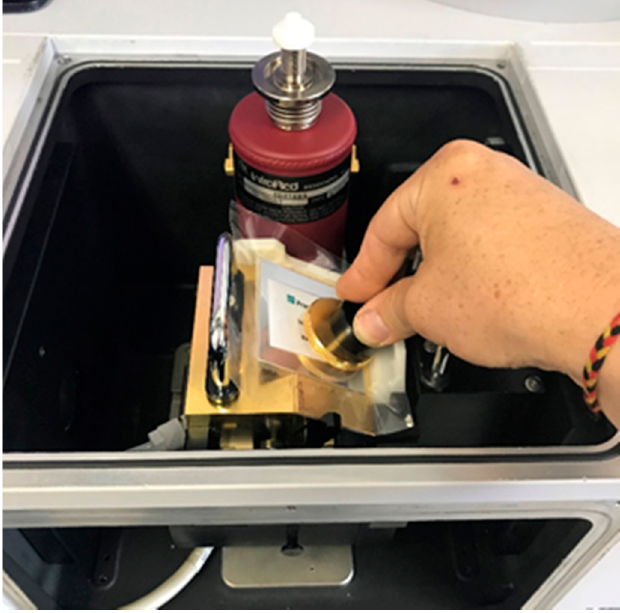
Figure A14. A view of Sample 1 being held in position over the top port. A measurement was taken of the wall as a reference in both sample orientations as a comparison to the use of the opposite port. As such, measurements of each sample were made in four configurations (BG-B_S-T, BG-T_S-B, BG-W_S-T and BG-W_S-B where BG and S refer to reference and sample measurement positions respectively and B, T and W to the bottom port, top port or wall). The measurement of the wall was not exactly replicable each time, as a makeshift stopper was used to position the internal sphere mirror each